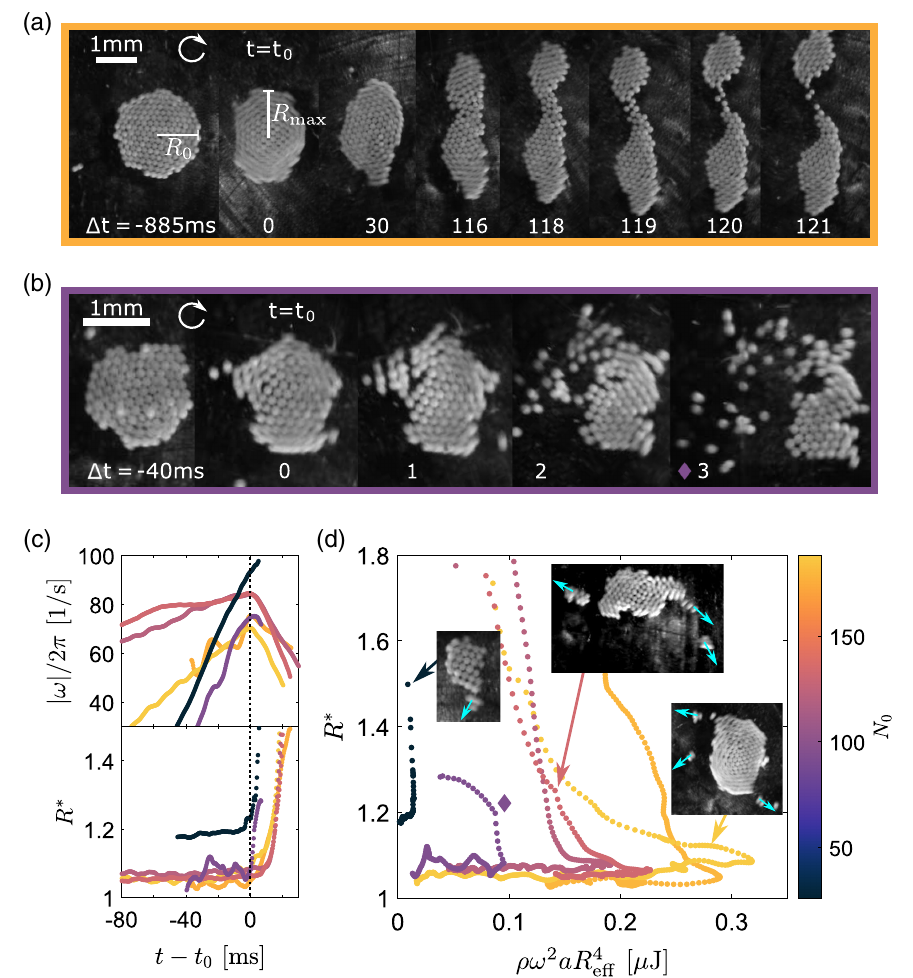
FIG. 3. Levitated granular rafts exhibiting emergent liquidlike behavior. (a) Sequence of images from below, showing the deformation of an initially circular raft that rotates in the clockwise direction. As the raft gains angular momentum, it elongates into an ellipse (at t ¼ t ρω 2 aR 4 is at its maximal value) and then splits into two smaller rafts. The corresponding traces are 0 , where the kinetic energy eff shown in orange in panels (c) and (d) (second largest raft). (b) Sequence of images from below, showing the deformation of a smaller raft, at first also by elongating (at t ¼ t 0 ) but then by shedding particles. The corresponding traces are shown in purple in panels (c) and (d) (second smallest raft), with the diamond marking the image at time t ¼ 3 ms in (b). (c) Example time series of the absolute value of the number of rotations per second j ω j = 2 π (top panel) and the dimensionless shape parameter R (cid:2) of the levitated raft (bottom panel), as a function of the number of particles in the raft N 0 [see part (d) for the color key]. Before t 0 , the rafts spin faster without deforming; after t 0 , the rafts change shape, shed weakly bound particles, and eventually split into multiple pieces. Raw data are filtered using a moving- average filter, with a width of 20 data points (7 ms) to obtain the data in panels (c) and (d). (d) Evolution of the dimensionless shape parameter R (cid:2) , as a function of the kinetic rotational energy of the drop ρω 2 aR 4 , for rafts with several different N 0 . The inset images eff show the rafts at various points in the spinning process. After deformation into an ellipse, rafts can shed angular momentum by losing small clusters of weakly bound